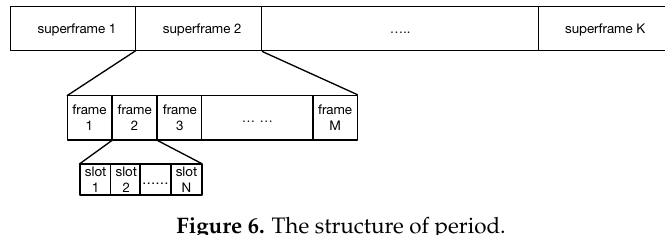
Figure 6. The structure of